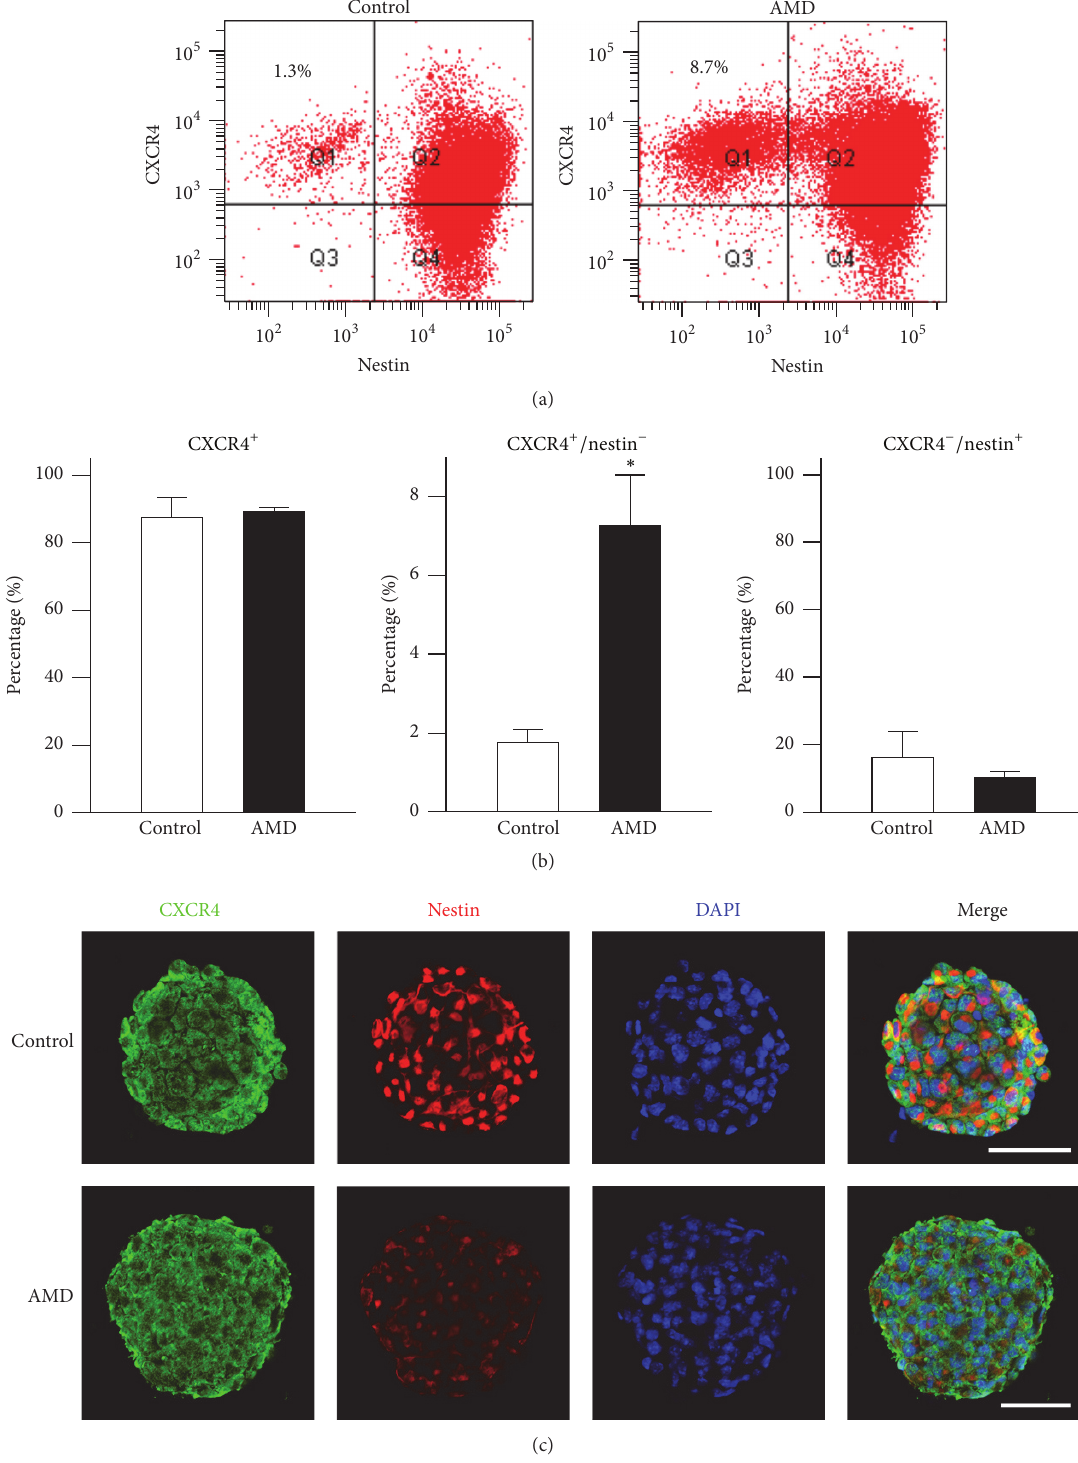
Figure 4: AMD treatment increased the percentage of nestin − cells in CXCR4 + population. (a) Primary neurospheres treated with either PBS or AMD were collected for flow cytometric analysis. Numbers in the quadrants indicate the percentage of CXCR4 + /nestin − cells. (b) Quantification of CXCR4 + cells (left panel), CXCR4 + /nestin − cells (middle panel), and CXCR4 − /nestin + cells (right panel) in control or AMD-treatedgroup.(c)RepresentativeimagesshowingCXCR4(green),nestin(red),andDAPI(blue)inPBS-orAMD-treatedneurospheres. Results are representative of three independent experiments with neurospheres from three independent litters. Data represent the mean ± SEM, ∗ 𝑝 < 0.05 , Student’s 𝑡